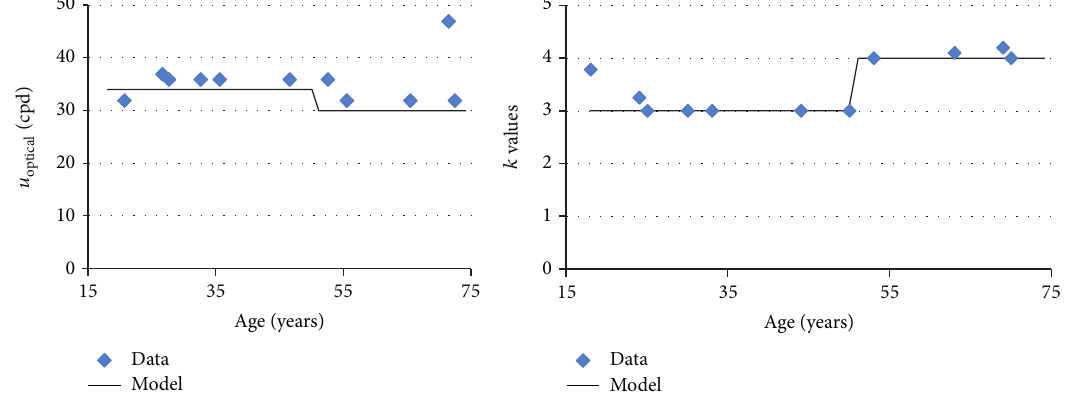
Figure 4: Estimates of 𝑢 and 𝑘 as a function of age, using CSF data from Owsley et al., Tulunay-Keesey et al., and Elliott et al. [21, 65, 66]. opt